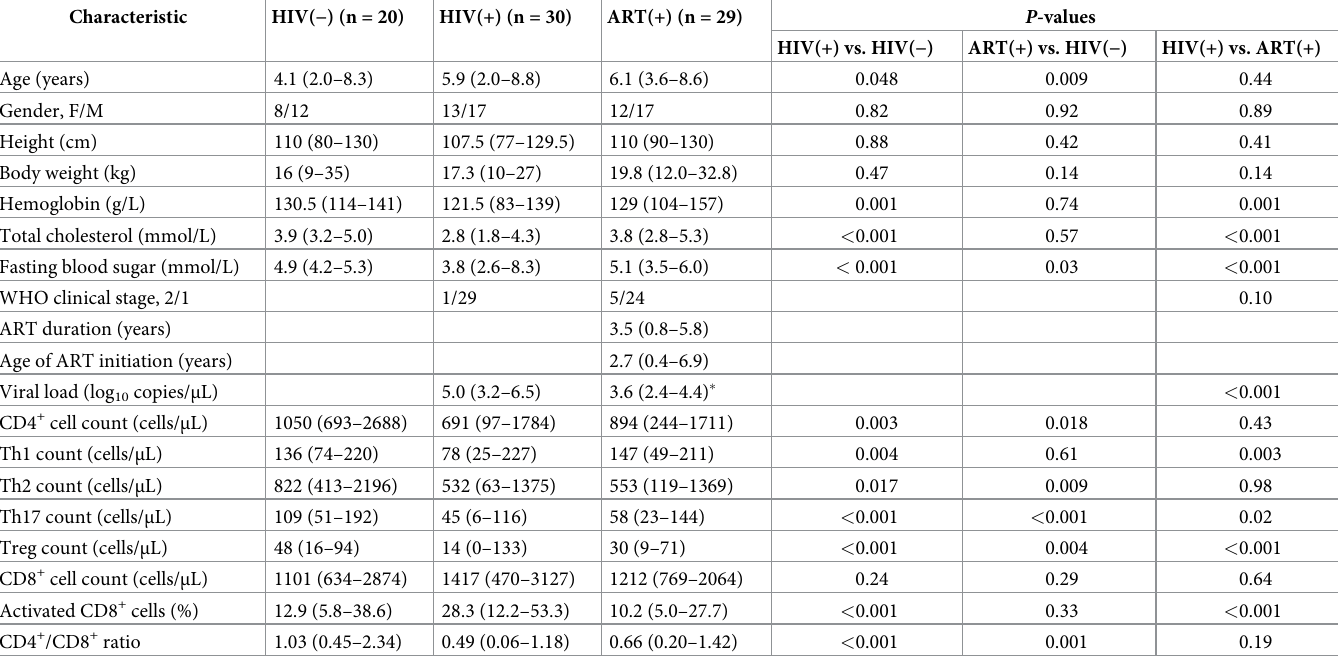
Values are given as the median (range) or the number of patients. F: female: M: male; HIV(+): children with HIV and not treated with ART; ART(+): children with HIV and treated with ART; HIV( − ): children not infected with HIV. P -values are based on the Mann-Whitney U test, except for the gender and WHO clinical stage comparison, which is based on the chi-squared test or Fisher’s exact test. � Viral load was undetectable in 22 children in the ART(+)